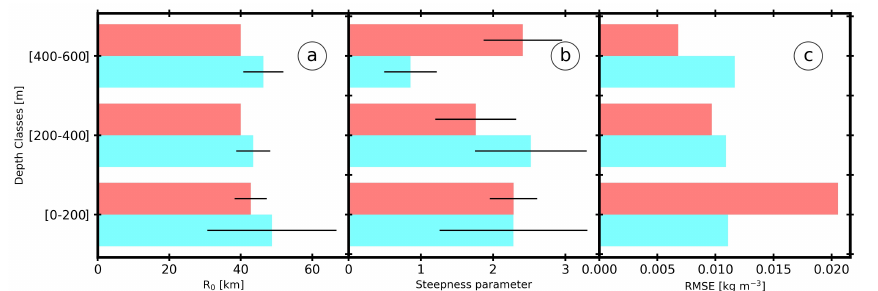
Figure 12. ( a ): Variation CE and AE radii. Figure ( b ): Steepness parameter α . Figure ( c ): Potential density RMSE error. The different figures are presented for three depth classes; the blue bars represent the AE and the red bars the CE.